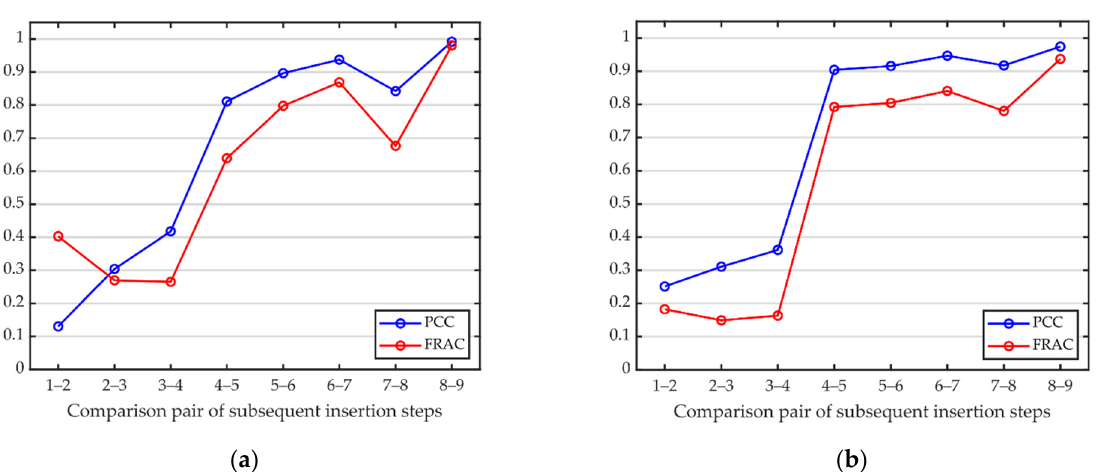
Figure 6. ( a ) PCC versus FRAC development during insertion without soft tissue in AP direction. ( b ) PCC versus FRAC development during insertion without soft tissue in ML direction.